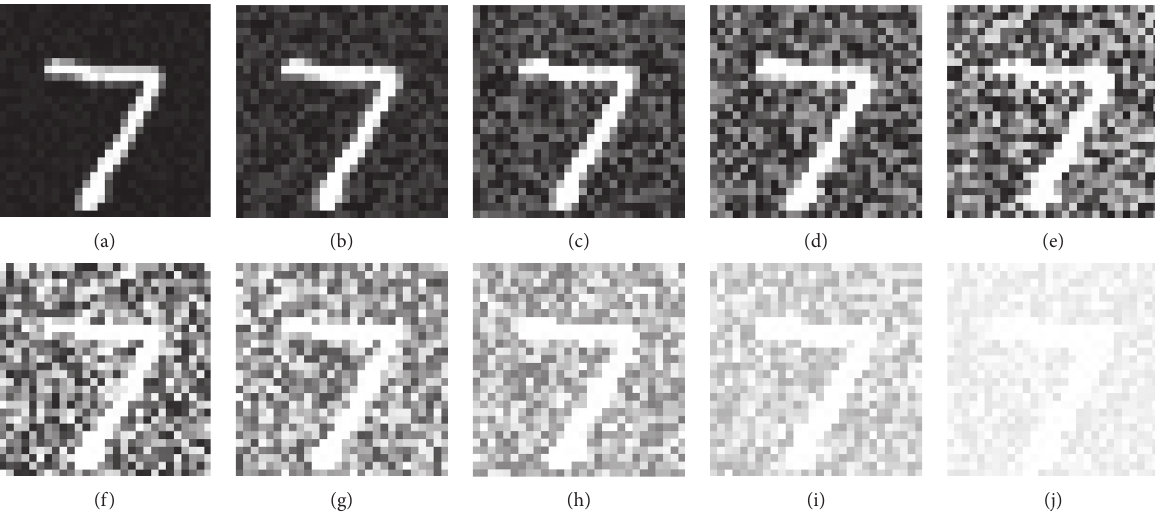
Figure 15: Testing image is disturbed at a noise level of (a) {0, 25}, (b) {0, 76}, (c) {0, 127}, (d) {0, 178}, (e) {0, 229}, (f) {25, 255}, (g) {76, 255}, (h) {127, 255}, (i) {178, 255}, and (j) {229,